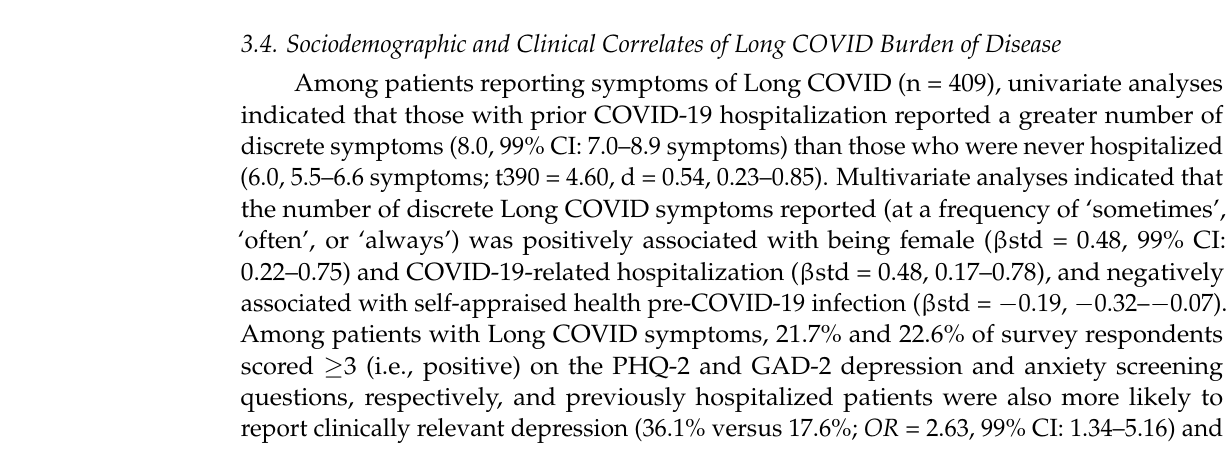
Table 1. Participant sociodemographic and clinical characteristics.